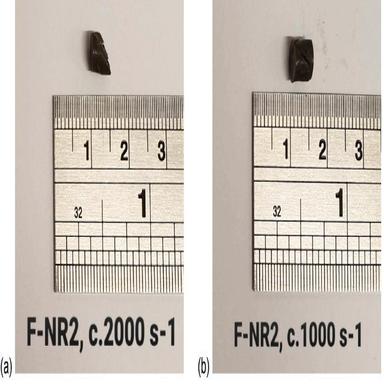
Post-mortem examination for high strain rate experiments at − 60 ◦C for F-NR2 at (a) c. 1000 s − 1 and (b) c. 2000 s − 1 .